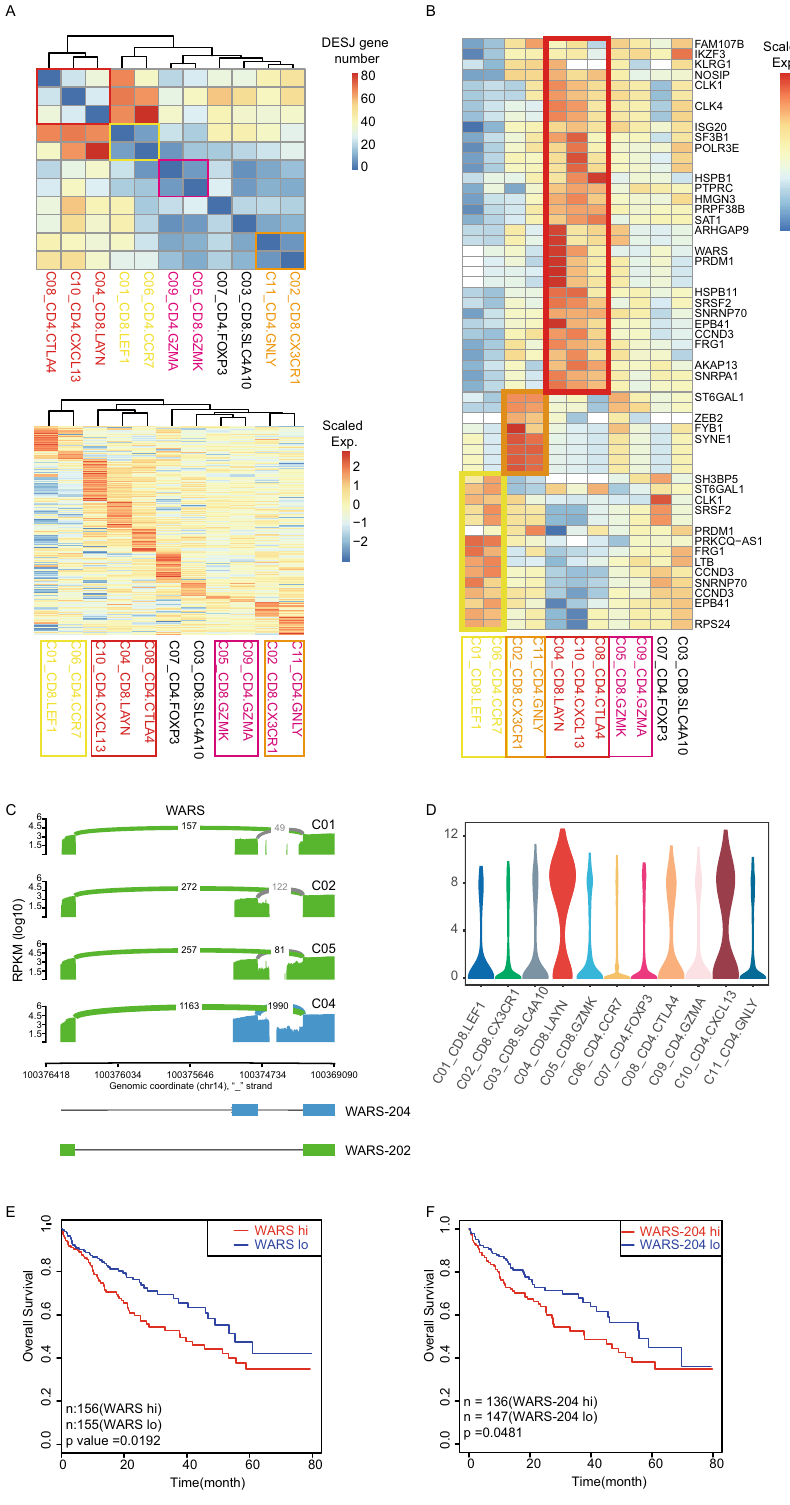
Figure 3. T cell heterogeneity at the splicing level. ( A ) Upper: Heatmap of DESJ gene number between pairwise clusters across T cells. Below: z-score normalized mean expression of all DESJ in each T cell cluster. Boxes with different colors highlight the patterns of different functional T subtypes. ( B ) z-score normalized mean expression of selected DESJ with similar functions. ( C ) Sashimi plots illustrating the read distribution of WARS in CD8 + T cells from the P0508 patient. WARS-204 is highly expressed in exhausted T clusters (C04_CD8.LAYN). ( D ) Violin plots comparing the expression of WARS among 11 T cell clusters. ( E ) A disease-free survival (DFS) curve based on TCGA HCC data showing that patients with higher expression of WARS had a poor prognosis. ( F ) DFS curve based on the TCGA HCC cohort showing that higher expression of WARS-204 in tumor is associated with bad